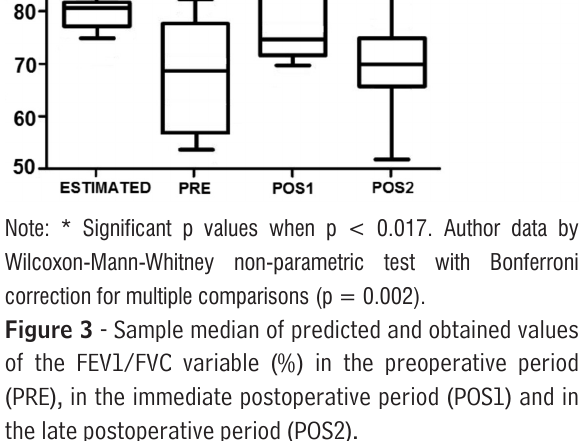
Figure 3 - Sample median of predicted and obtained values of the FEV1/FVC variable ( ) in the preoperative period (PRE), in the immediate postoperative period (POS1) and in % the late postoperative period